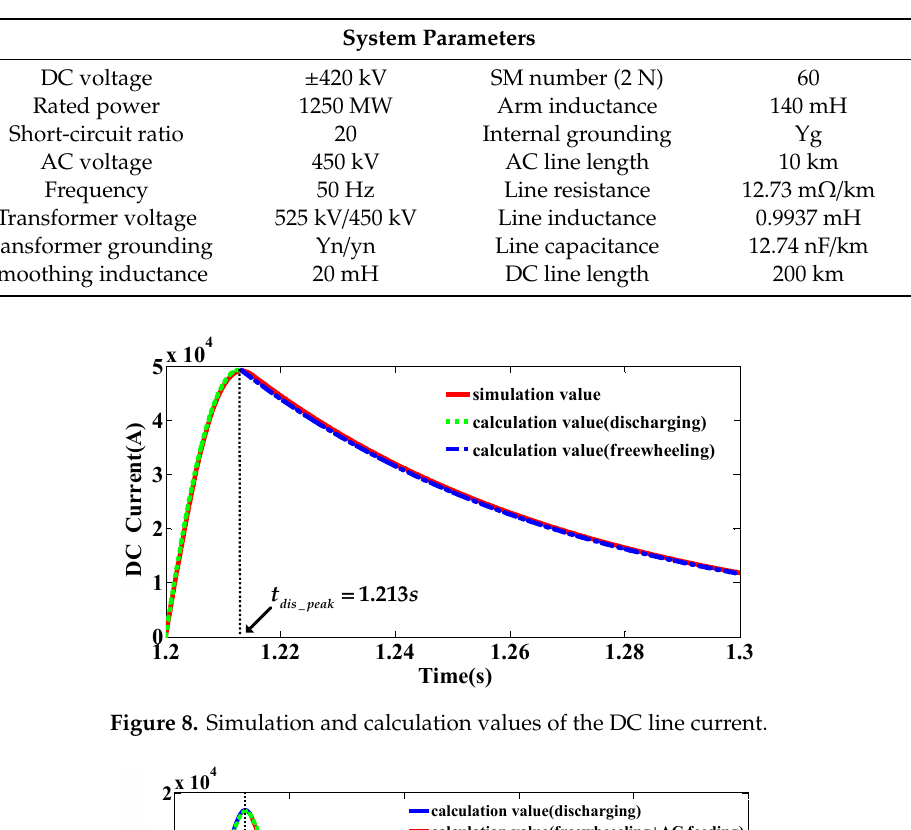
Table 1. Parameters of the modular multilevel converter-based high-voltage direct current system’s simulation model.